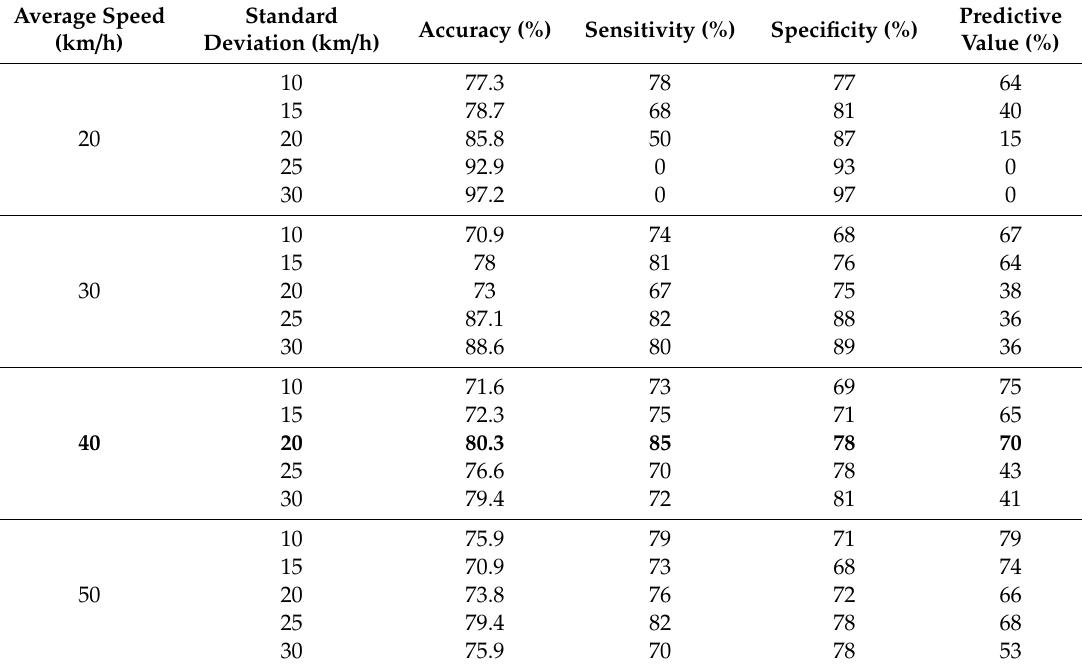
Figure 3. Line plot of the collected speed and electrodermal activity (EDA) data in the same time series for an evening session. Table 3. Models with various averages and standard deviations of vehicle